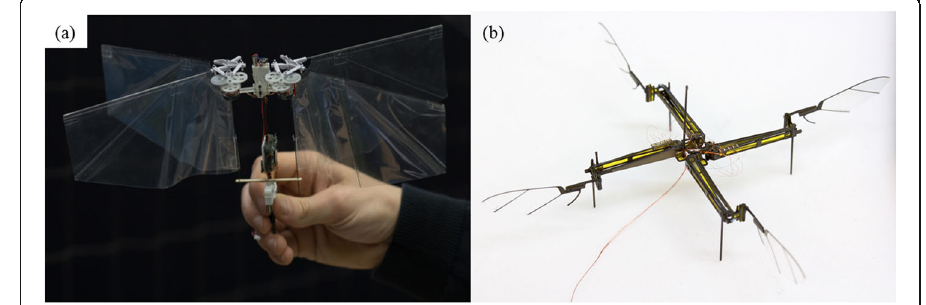
Fig. 1 Typical four-winged FMAV. a Delfly Nimble, b RoboBee